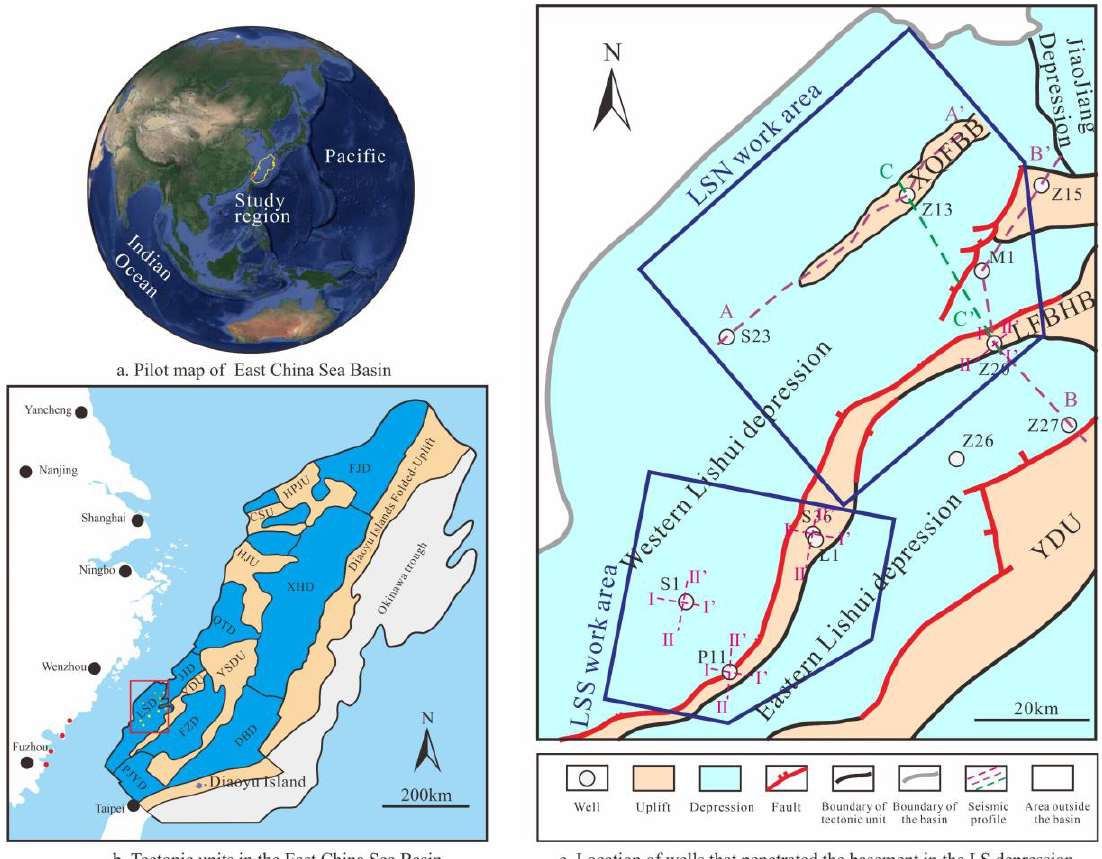
Figure 1. Location of LiShui Depression and wells in study area. Notes: In ( a ), the yellow line and red zone represent the ECSB and LS depression respectively. In ( b ), the red rectangle represents the area of ( c ) in the East China Sea Basin, blue areas represent depressions, beige areas represent uplifts, light blue areas represent areas outside the East China Sea Basin, white areas represent land, red points represent outcrop sampling sites, yellow points represent wells, and colored lines represent seismic profiles. In ( c ), the blank area in the upper left represents the area outside the basin and the dark blue polygons represent the location of the seismic work area. FJD—FuZhou Depression;